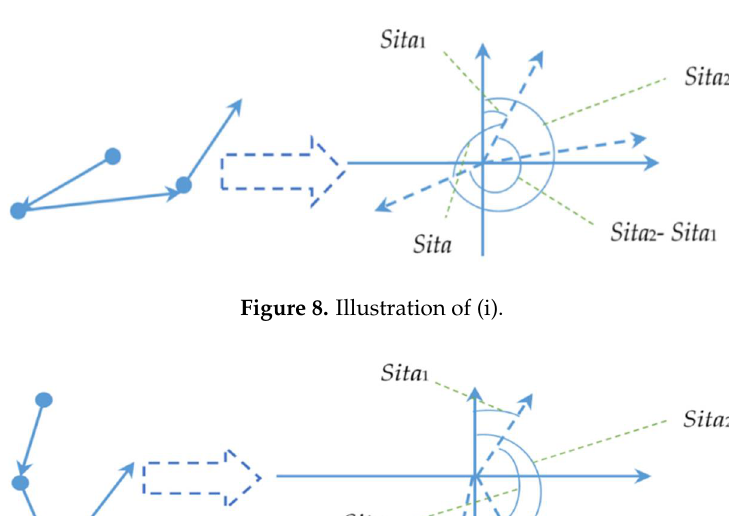
Figure 7. Three GPS data points selection method.